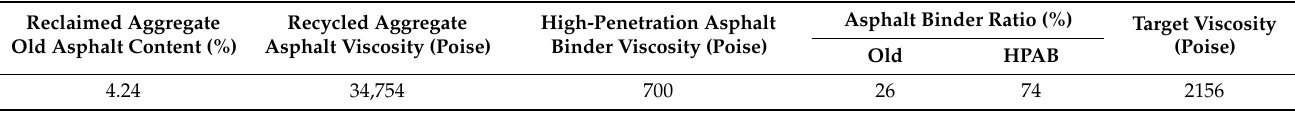
Figure 4. Design of optimized viscosity and binder content. Table 4. Viscosity test of HPAB mixtures.